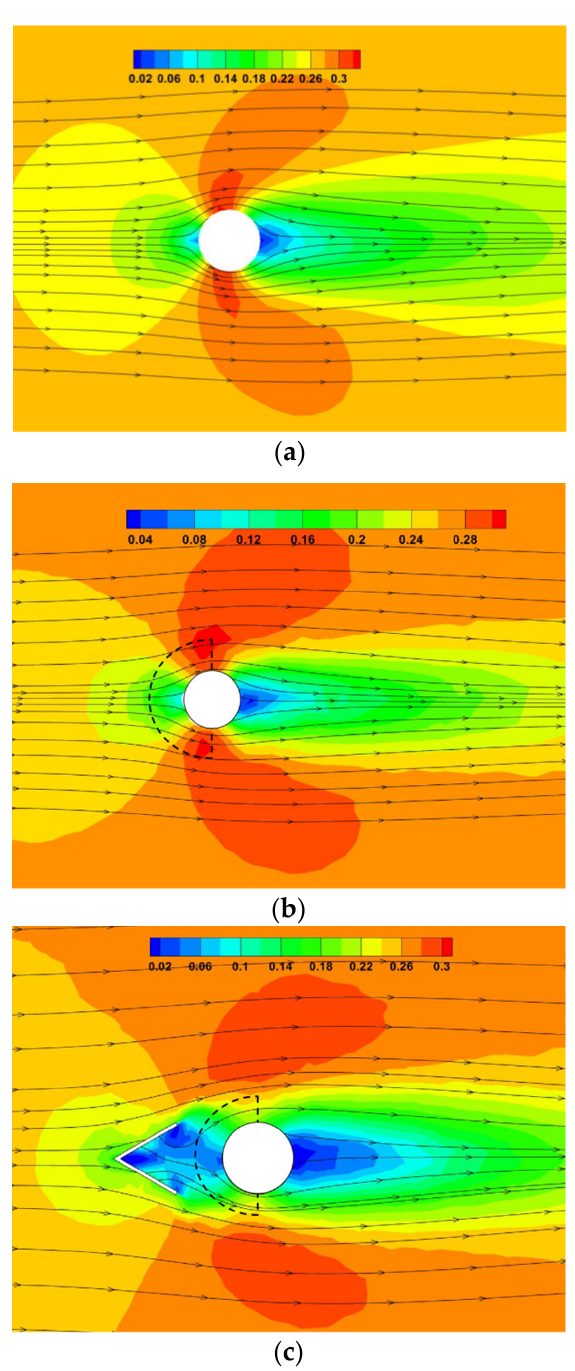
Figure 10. Streamlines and velocity contours at Z = 1 cm. ( a ) Single pier; ( b ) Pier with ring-wing plate; ( c ) Pier with combined device.